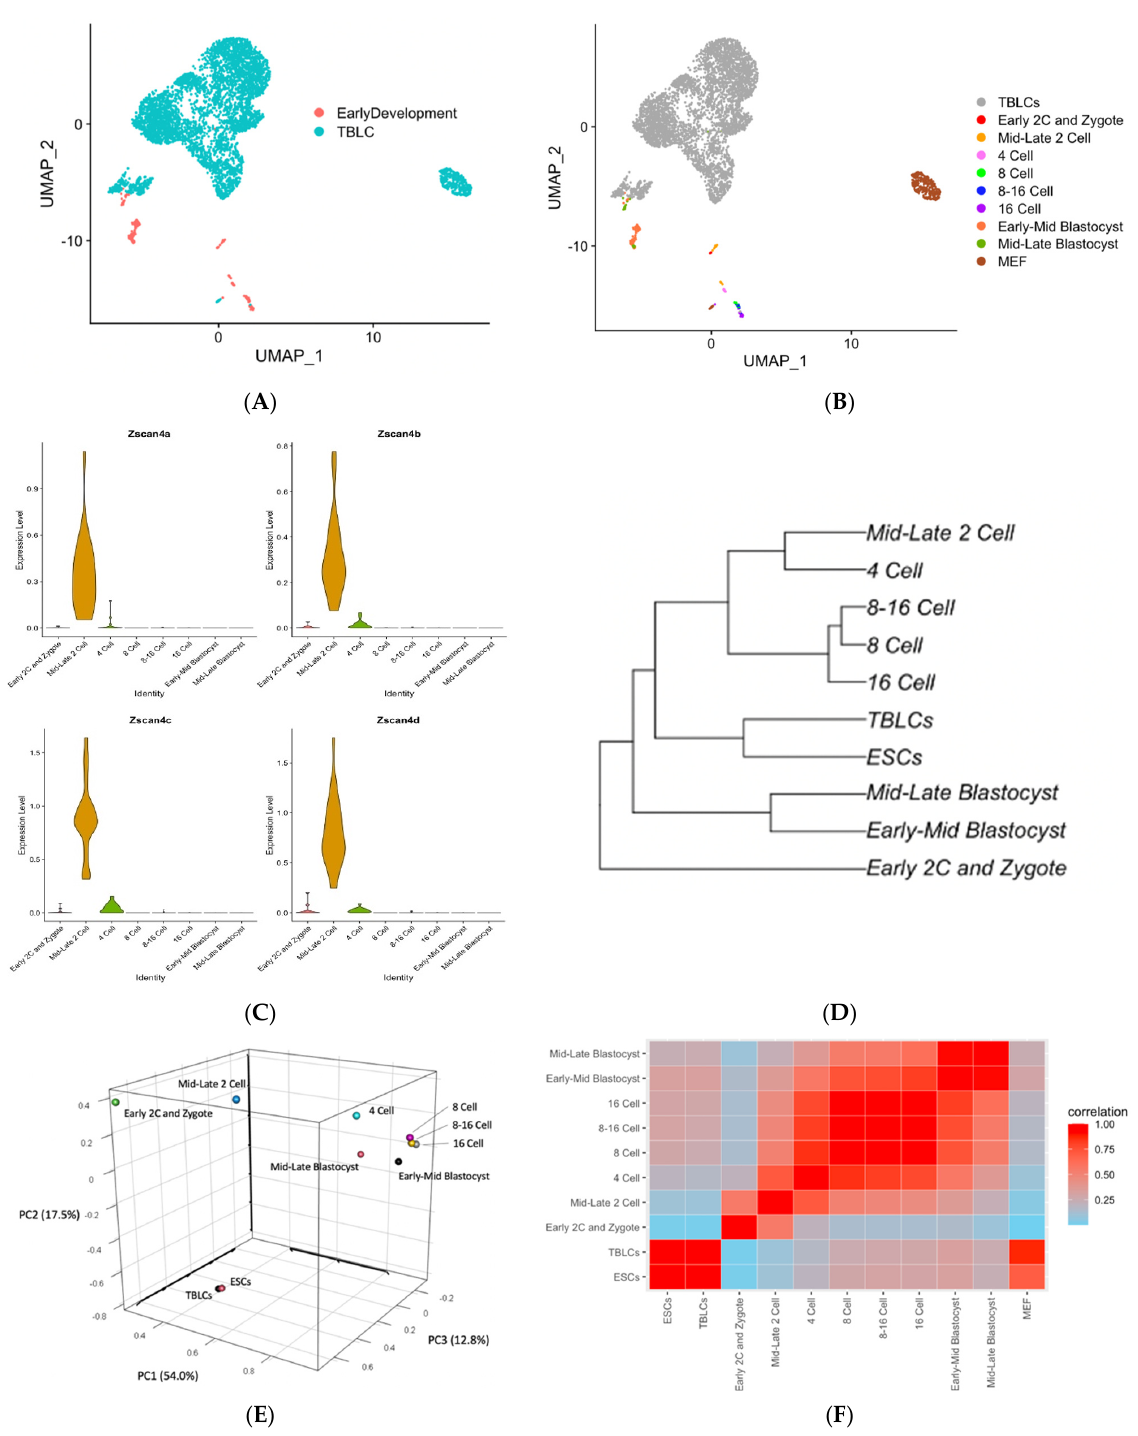
Figure 3. Transcriptomic profile comparisons between mouse early embryonic developmental stages and TBLCs. ( A ) UMAP dimensional reduction plot of mouse early embryonic developmental stages and TBLCs were separated by original identity. ( B ) UMAP dimensional reduction plot of early embryonic developmental stages of mouse cell clusters and TBLCs. ( C ) Violin plots displaying the expression profiles of Zscan4a – d across different stages of early mouse embryonic development clusters. The y -axis scale represents log-transformed gene expression levels. ( D ) Hierarchical clustering tree of TBLCs, ESCs, and early mouse embryonic developmental stages based on global transcriptomic levels. ( E ) Principal component analysis (PCA) of TBLCs, ESCs, and early mouse embryonic developmental stages using the average of single-cell data shown in the first 3 PCs. ( F ) A correlation matrix of TBLCs, ESCs, and early mouse embryonic developmental stages at the global transcriptomic level using Pearson’s correlation coefficient method. Scale bar indicates the correlation